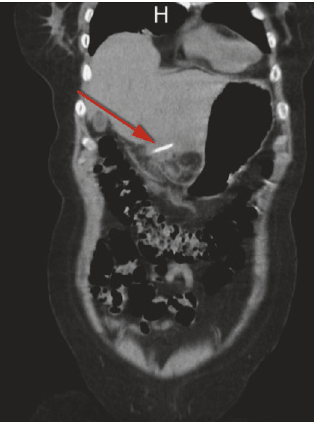
Figure 1: Coronal view CT scan of the abdomen and pelvis showing radiopaque FB in the liver (red arrow).